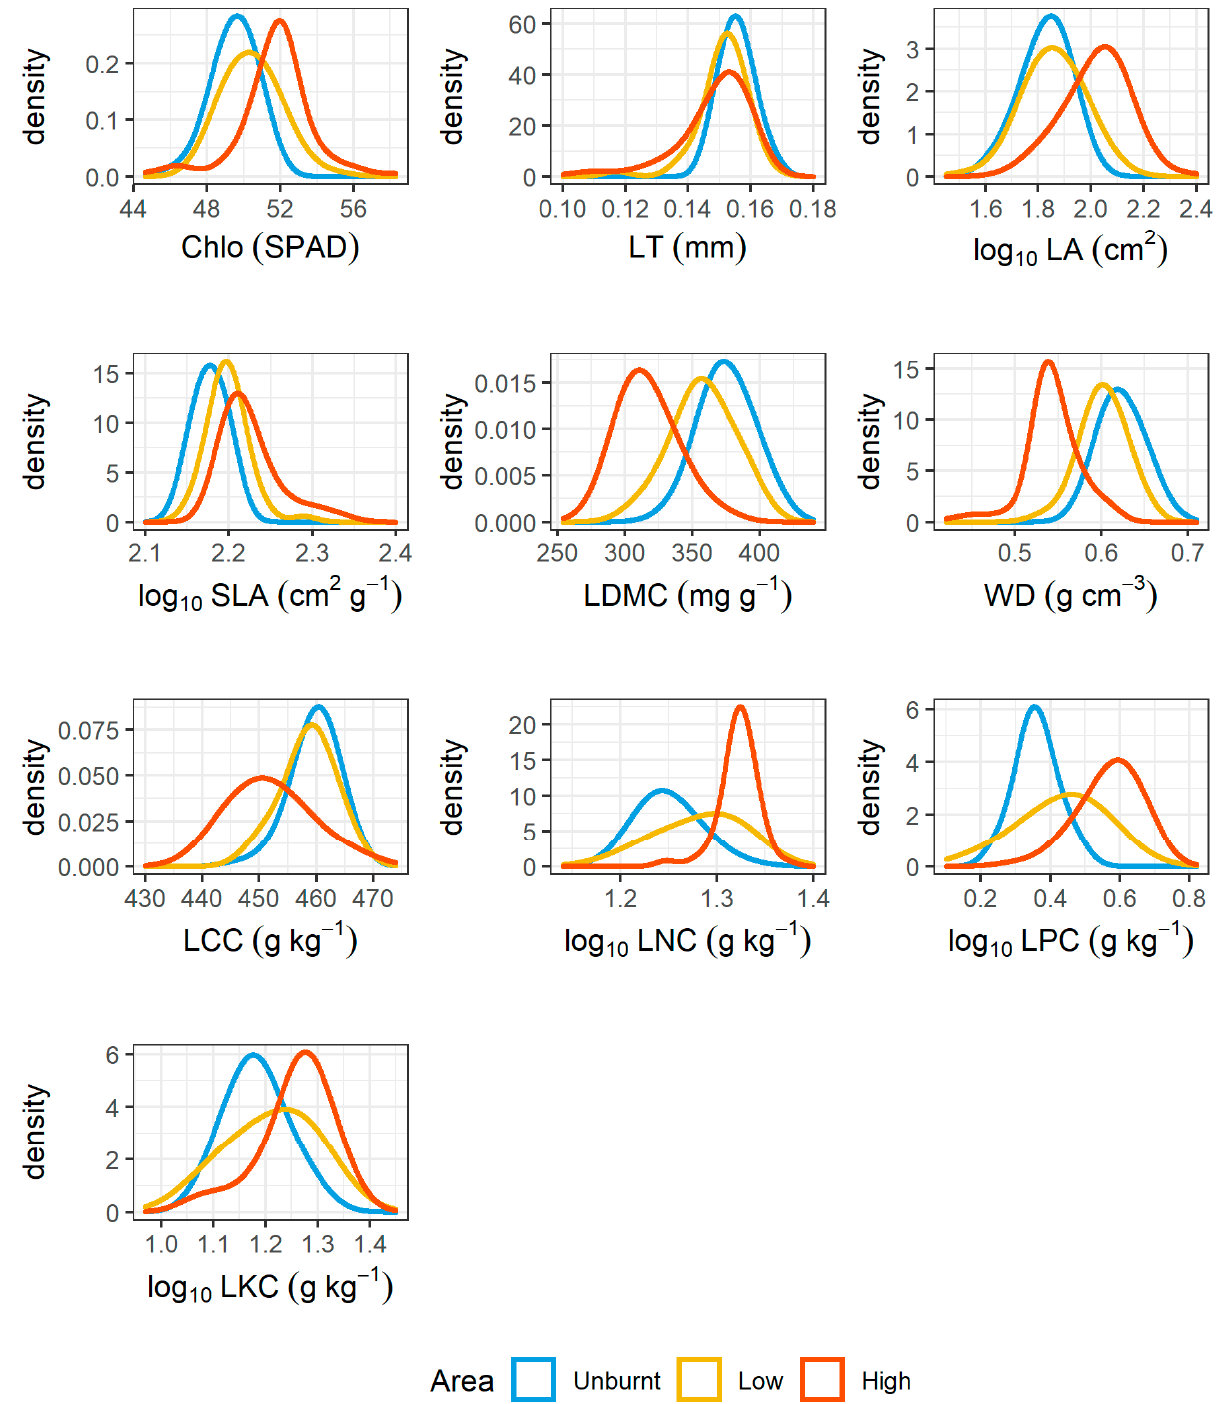
Figure 8. Kernel density estimate of post-fire community-weighted mean (CWM) of functional traits and fire intensity in Huai Kha Khaeng Forest Dynamics Plot, Thailand. Chlo, Chlorophyll content; LT, leaf thickness; LA, leaf area; SLA, specific leaf area; LDMC, leaf dry matter content; WD, wood density; LCC, leaf total carbon concentration; LNC, leaf total nitrogen concentration; and LPC, leaf total phosphorus concentration.